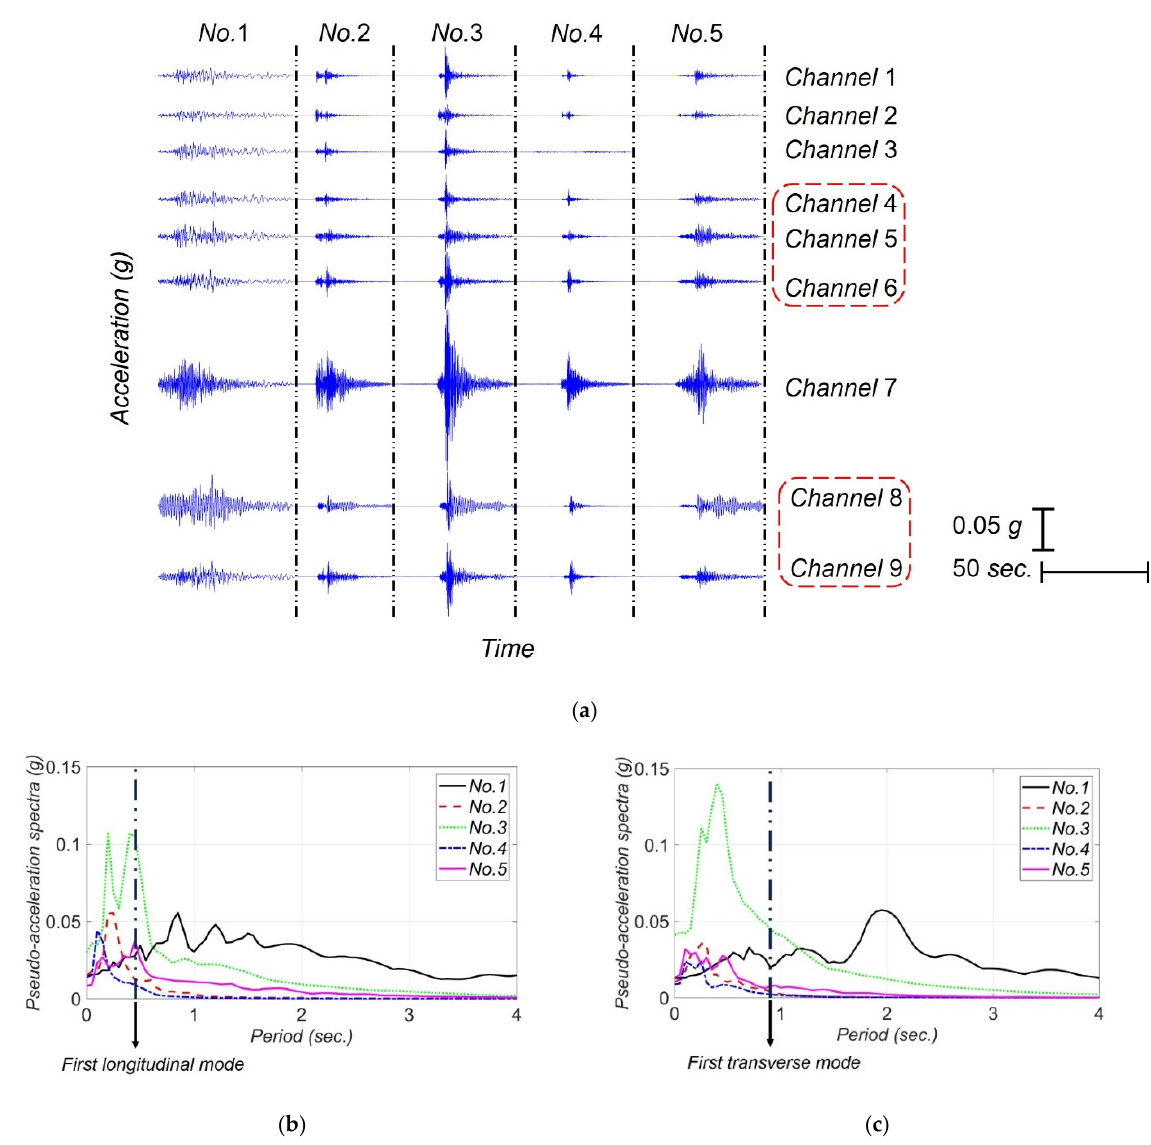
Figure 5. Earthquake data used for model updating: ( a ) recorded acceleation responses at the SRC bridge for earthquakes listed in Table 1, ( b ) pseudo spectral acceleration of FIMs projected in the longitudinal direction, and ( c ) pseudo spectral acceleration of FIMs projected in the transverse